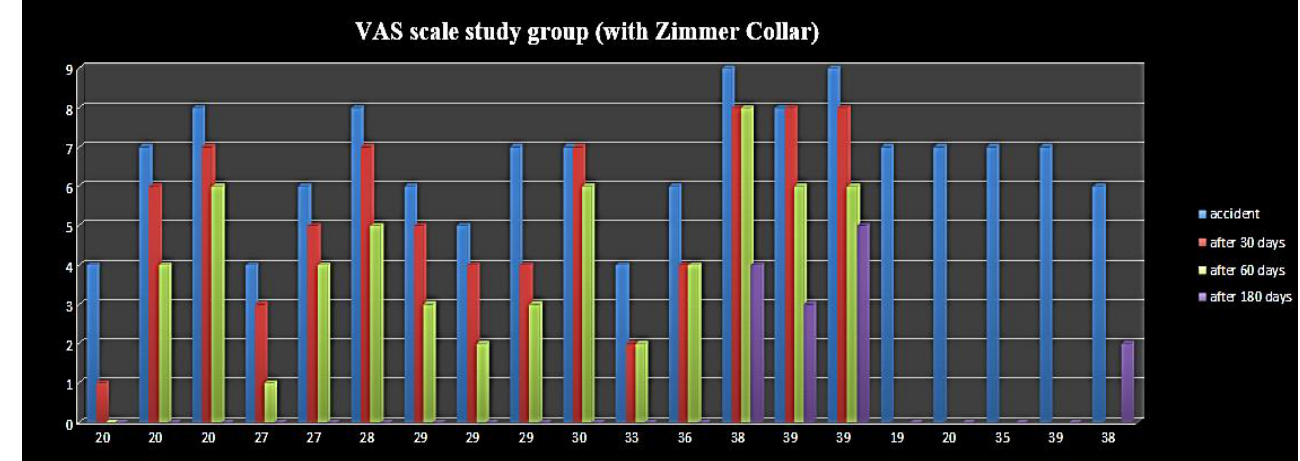
Table 3. Control group results (Zimmer collar non-users).